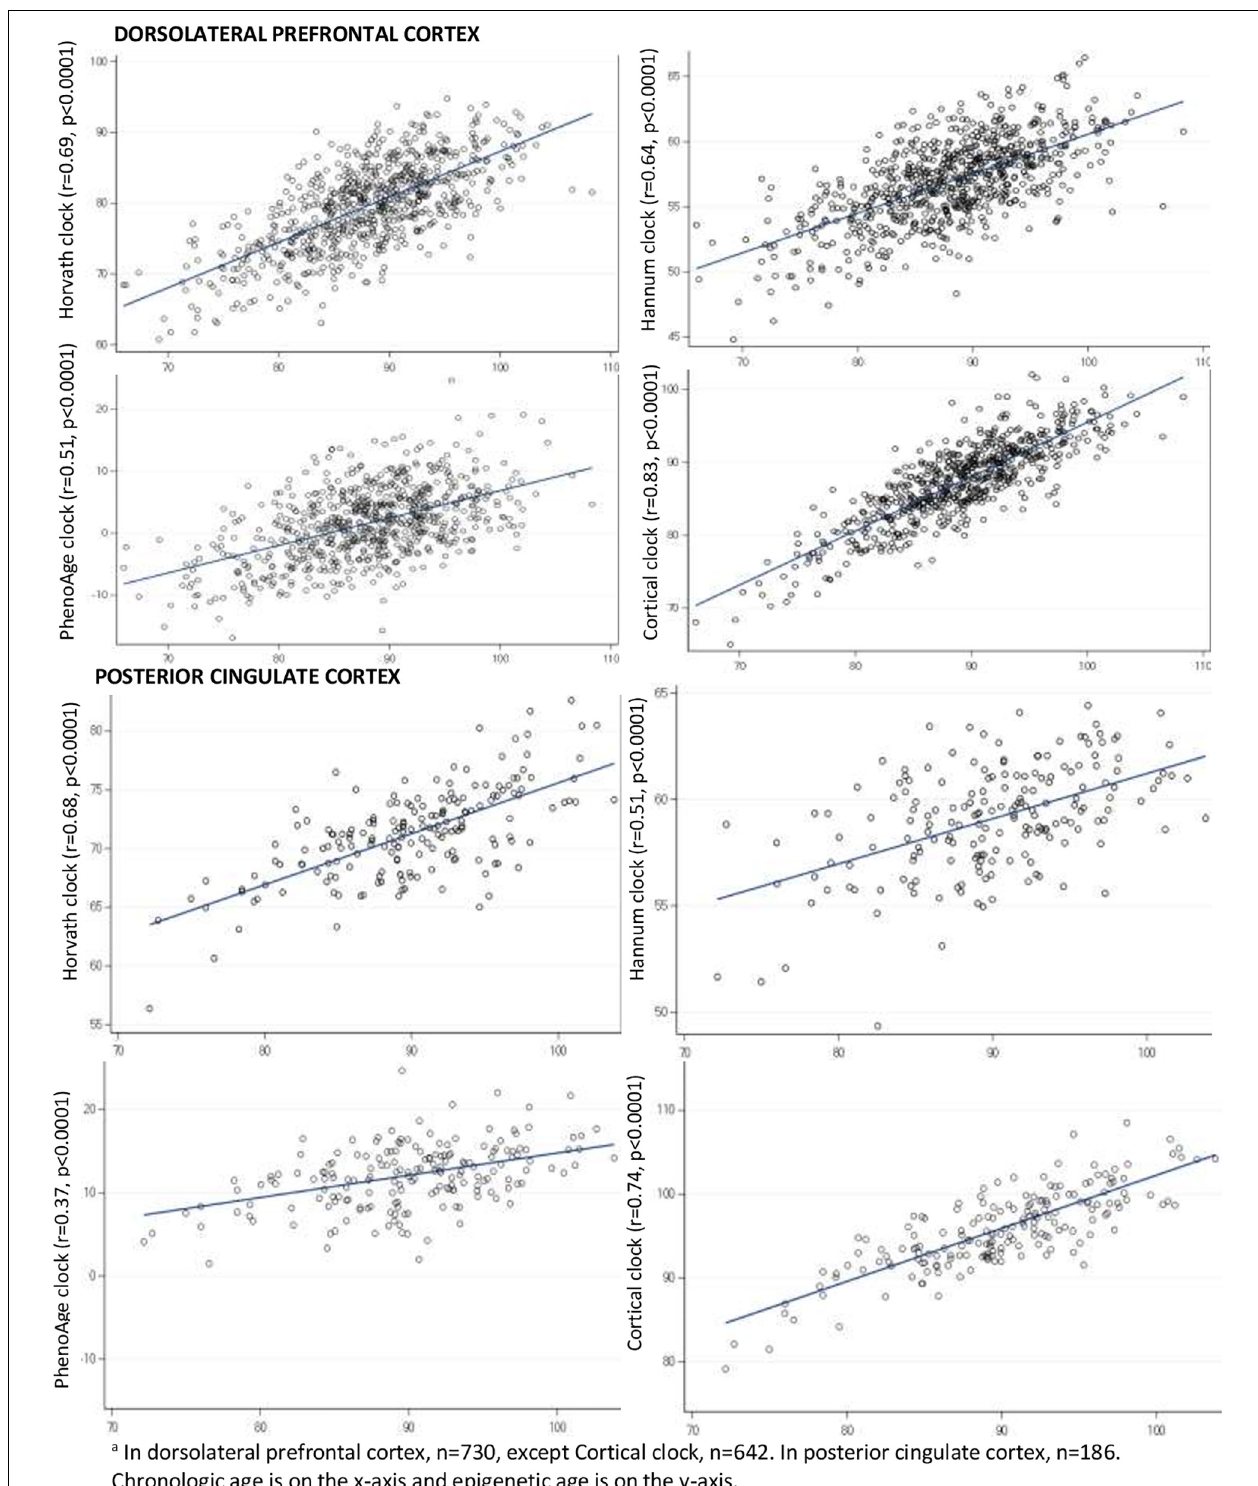
FIGURE 3 | Pearson correlations of epigenetic age to chronologic age in brain specimens a .